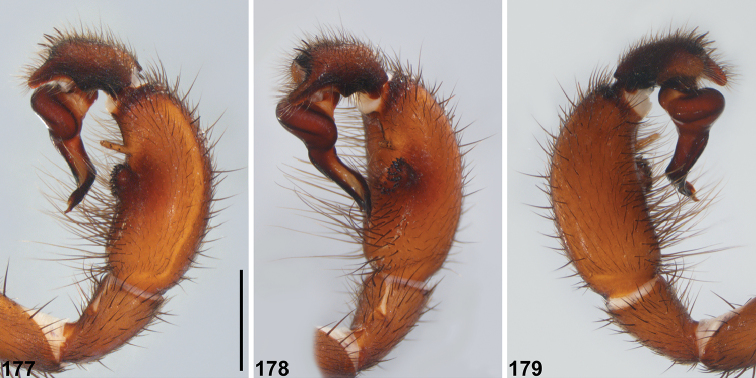

Idiosoma
gardneri sp. n., male holotype (WAM T139528) from Lesueur National Park (Western Australia; GES), pedipalp. 177 Retrolateral view 178 Retroventral view 179 Prolateral view. Scale bar 2.0.